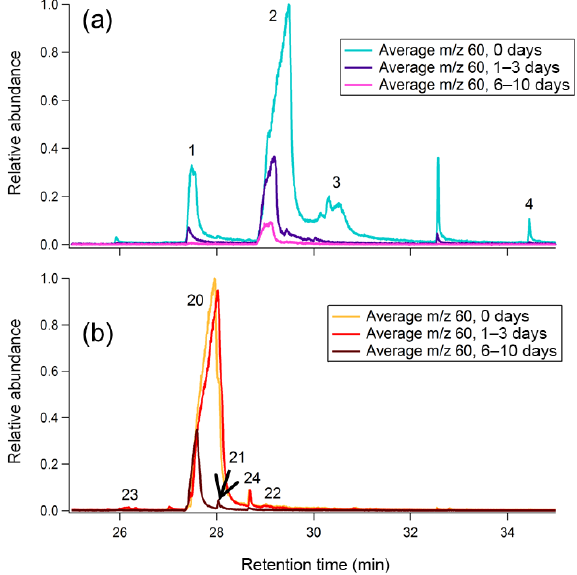
Figure 11. Average m/z 60 single-ion chromatograms (SICs) across the compound window for (a) leaf BBOA and (b) heartwood BBOA. For each plot, all traces are normalized to the point of high- est abundance within the average unaged chromatogram. Individual compounds are labeled according to identifications provided in the Supplement (Fig. S9; Table